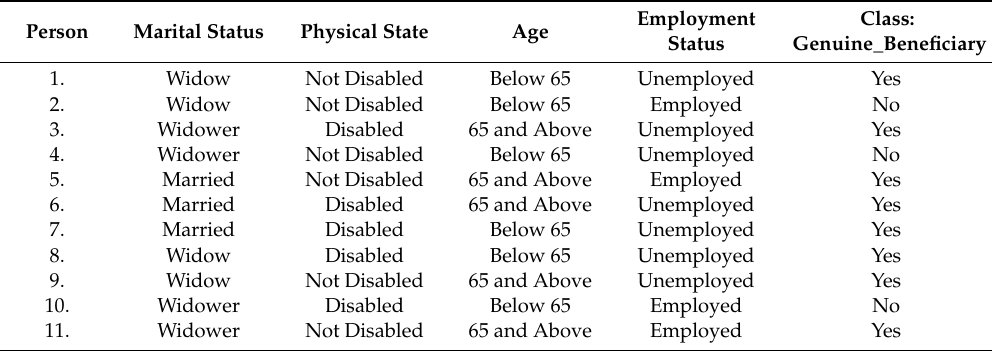
Table 3. A sample of the data of vulnerable